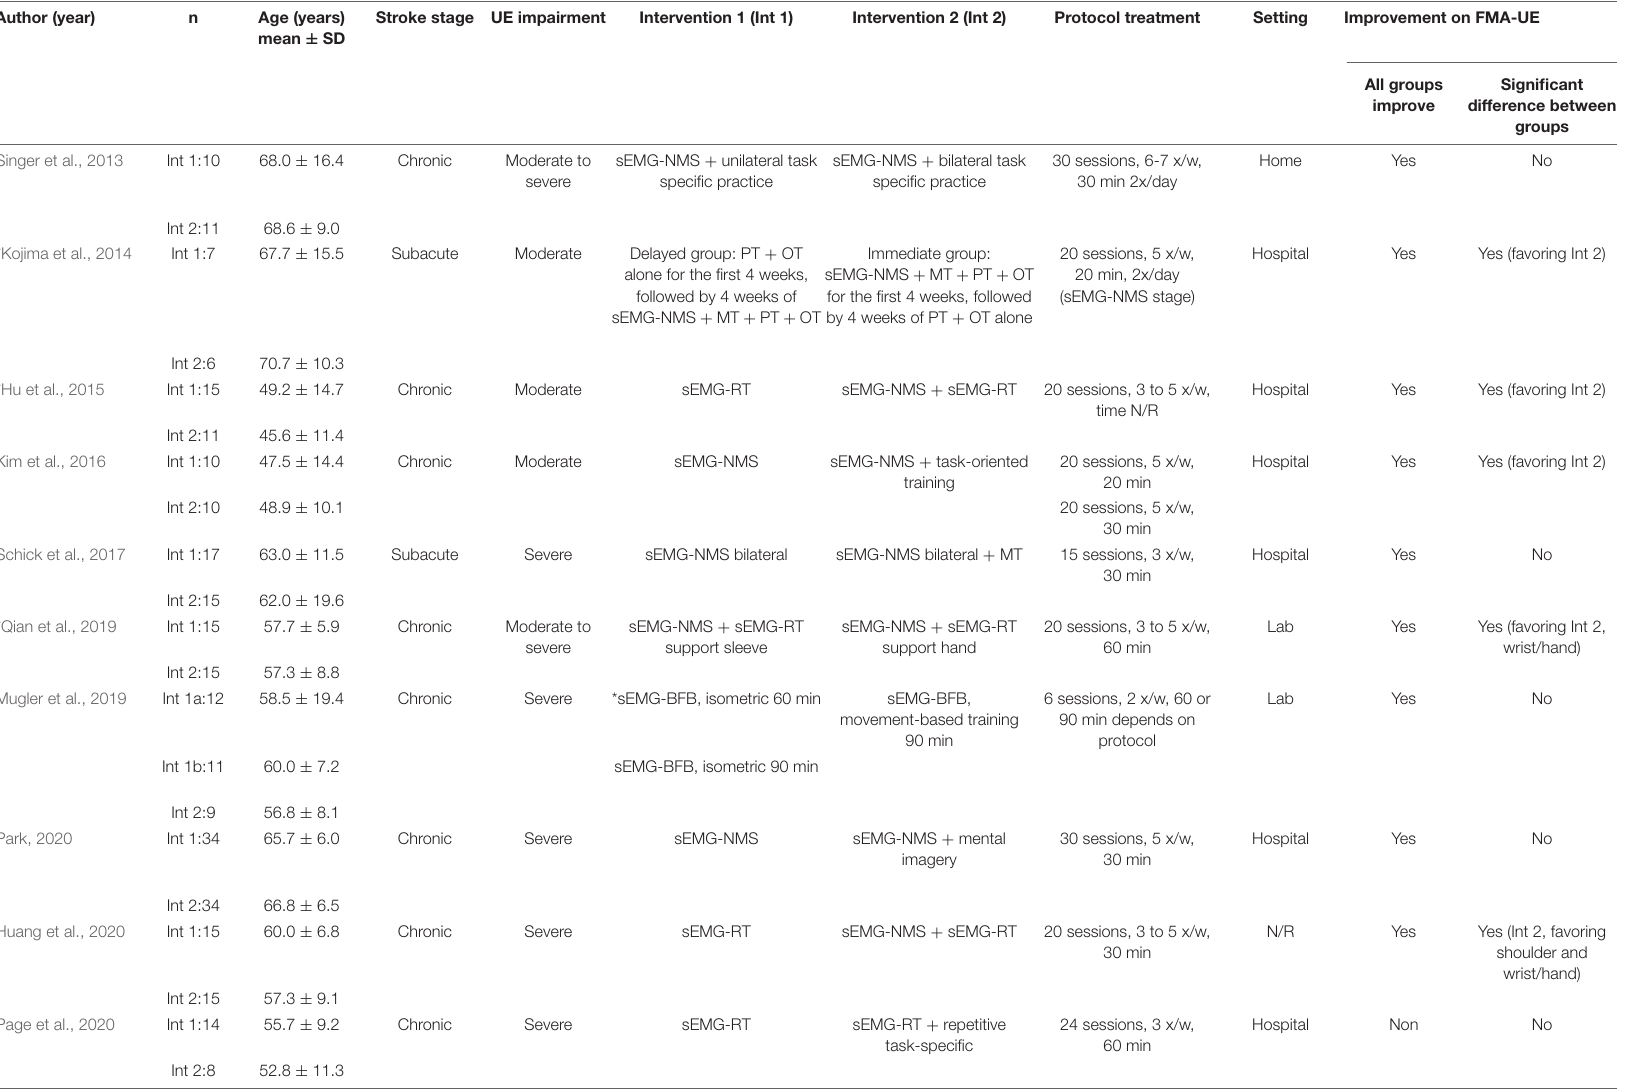
TABLE 4 | Characteristics of the included studies comparing sEMG intervention with another sEMG intervention.